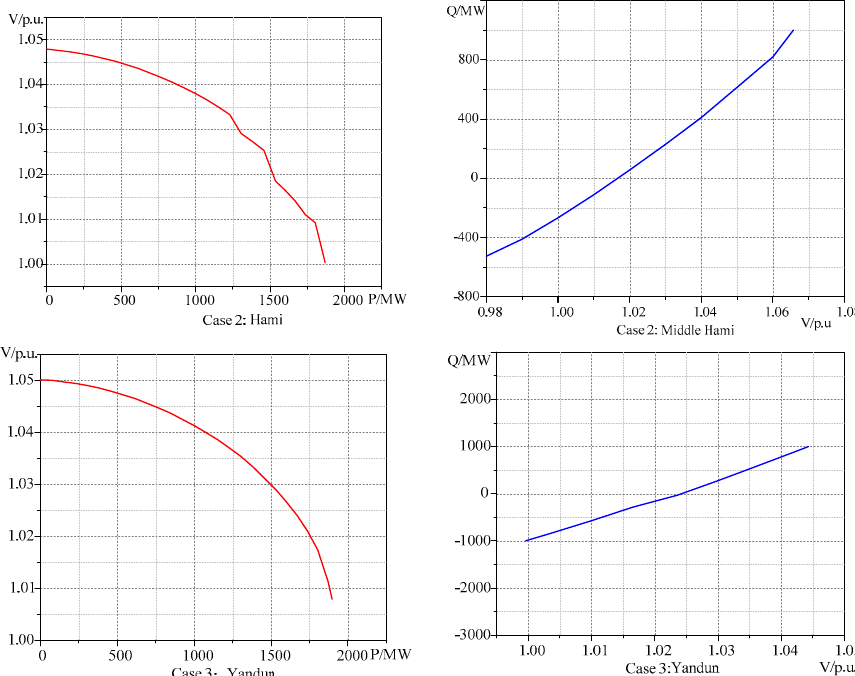
Figure 9. PV and QV curves of the three cases.